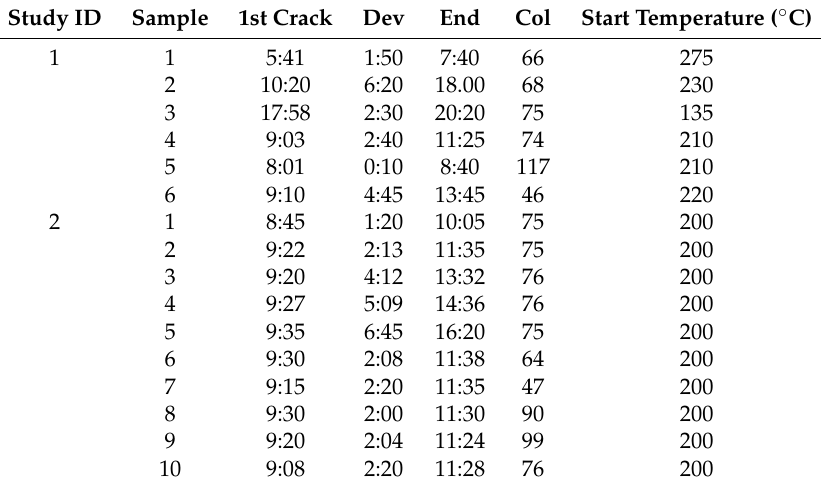
Table 2. Roasting conditions for all samples across all studies (Col = Roast colour, 1st Crack = time to first crack, Dev = development time), End = total roasting time. All roasting parameters are reported as time in min. The last two columns (Col) report the Agtron Gourmet value, a spectrophotometric measure indicating the colour of the roast (with a smaller number indicating darker roasts) and the starting temperature for each sample (air temperature when the beans enter the